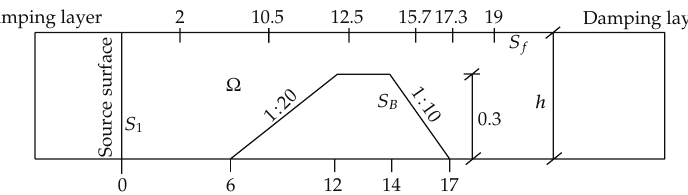
Figure 2: Definition sketch of wave propagating over a trapezoid bar.